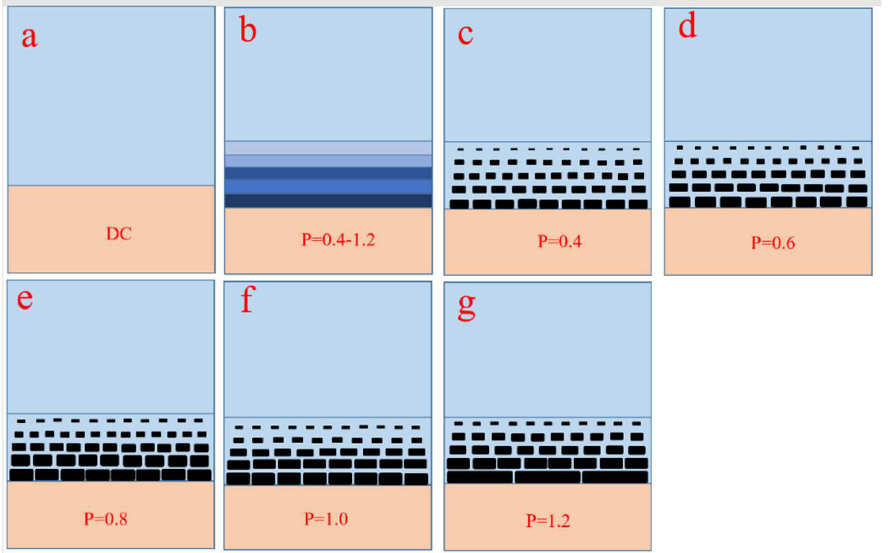
Figure 2. Model of traditional coating ( a ) and continuous transition coating (( b ): S1, ( c – g ):